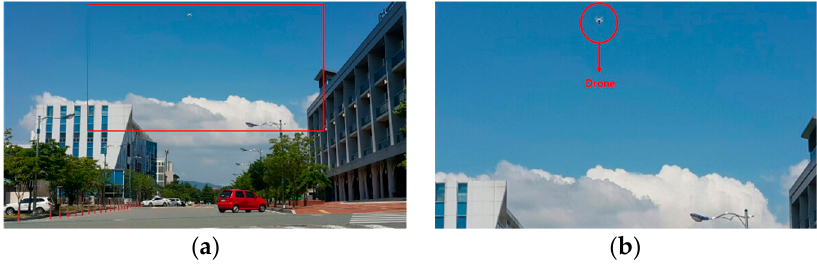
Figure 5. ( a ) Picture of a drone at a height of 15 m, ( b ) magnification of Figure 5a.